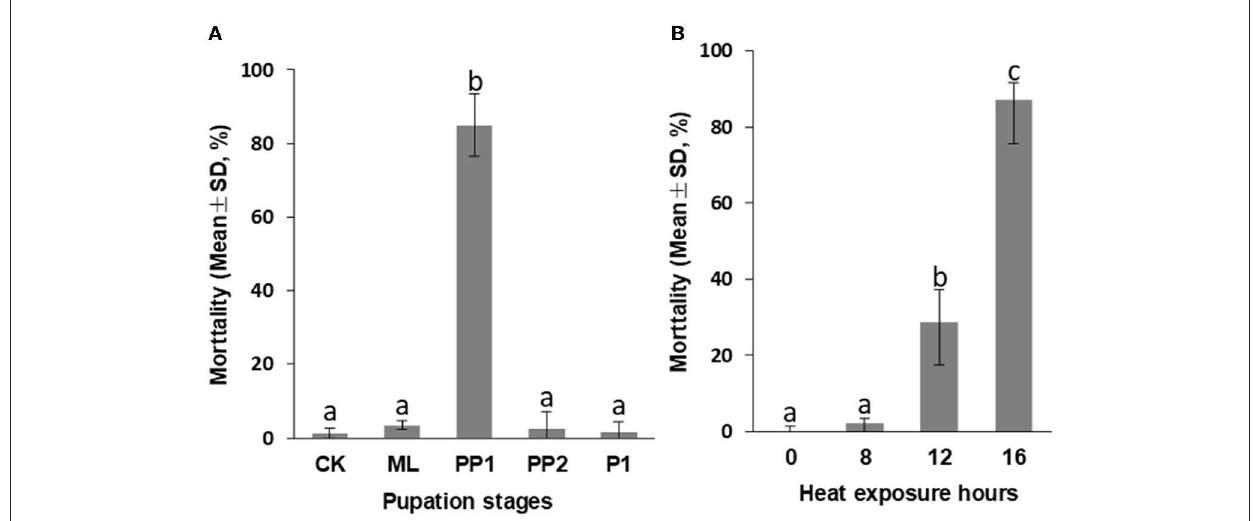
FIGURE1 Mortality of honeybee broods exposed to 40 ◦ C for 16h (A) and PP1 exposed to 40 ◦ C for 0 (CK), 8, 12, 16h (B) . CK, control group; ML, mature larva; PP1, the first day of prepupa; PP2, the second day of prepupa; P1, the first day of the pupa. The different letters in the lowercase indicate a significant difference at the P < 0.01